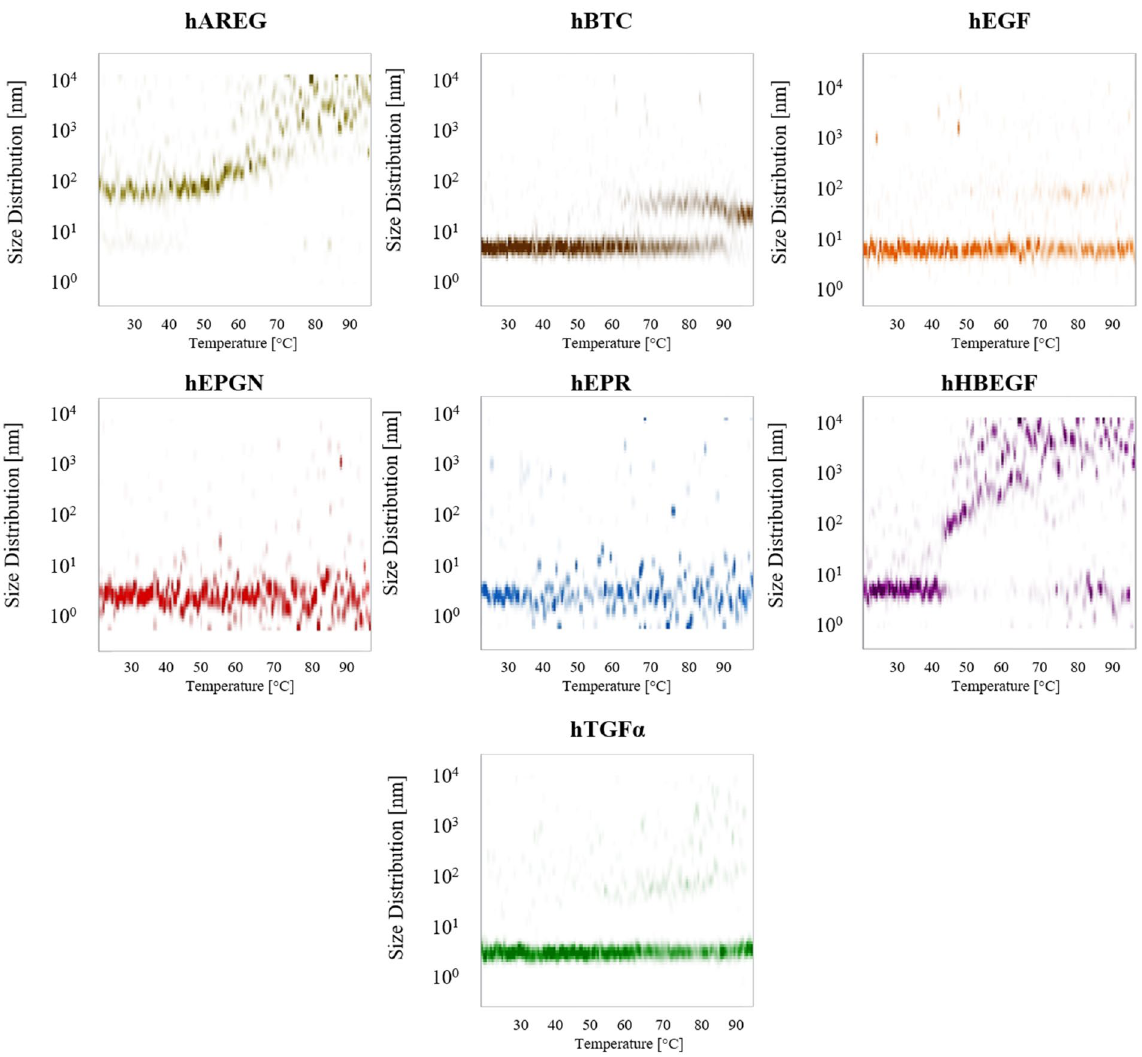
Figure 4. Particle size distributions (nm) for the seven growth factors as a relation of temperature increase from 20 to 95 °C as determined by DLS using non-reduced